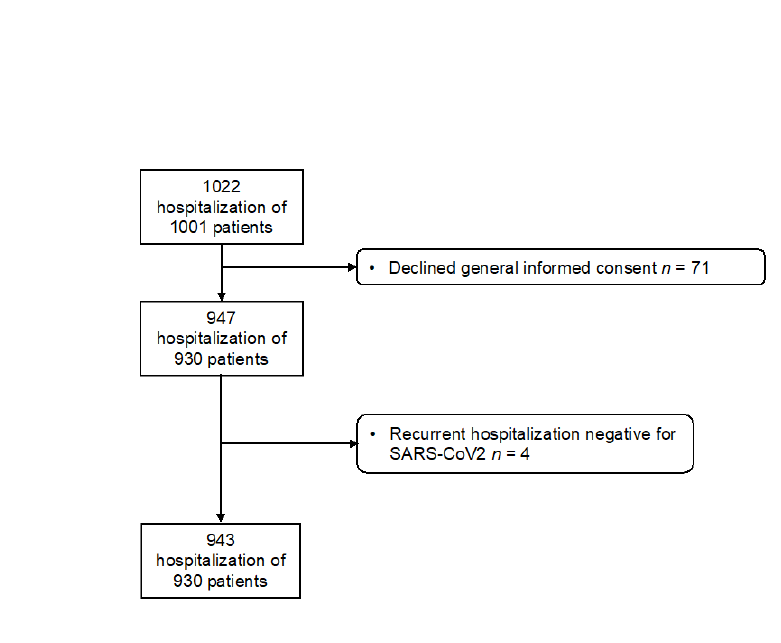
Figure S2 Study flowchart of the study